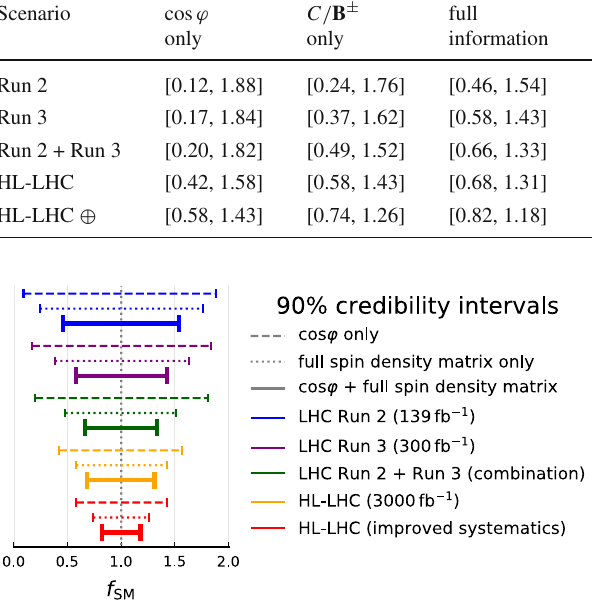
Fig. 3 Comparison of the 90% credibility intervals on f SM , according to the various scenarios described in the text of Sect. 3.2 building d -dimensional operators Q